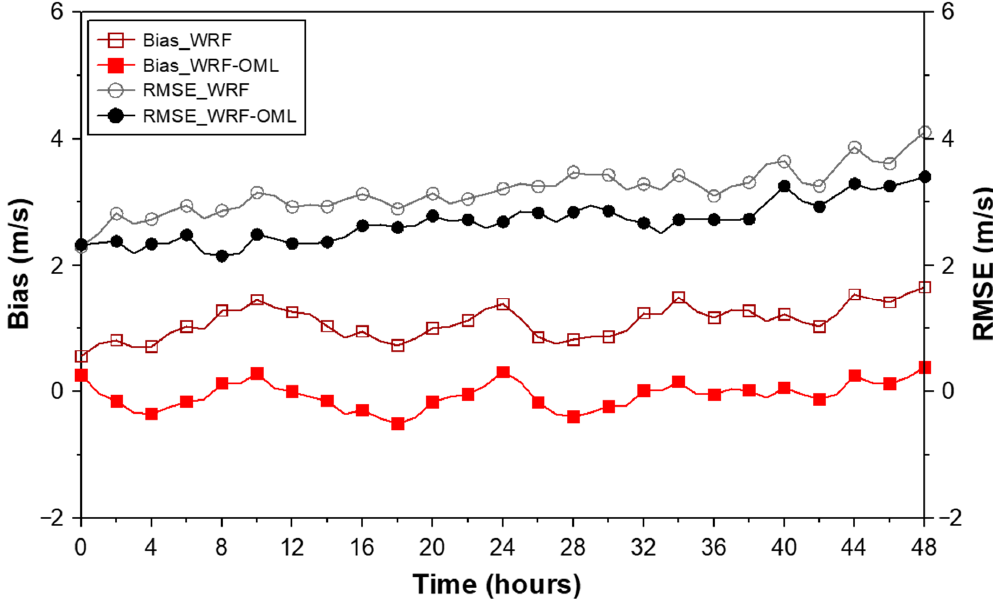
Figure 8. Bias and RMSE of simulated results using WRF and WRF-OML (wind speed at 94 m height) models with prediction time.